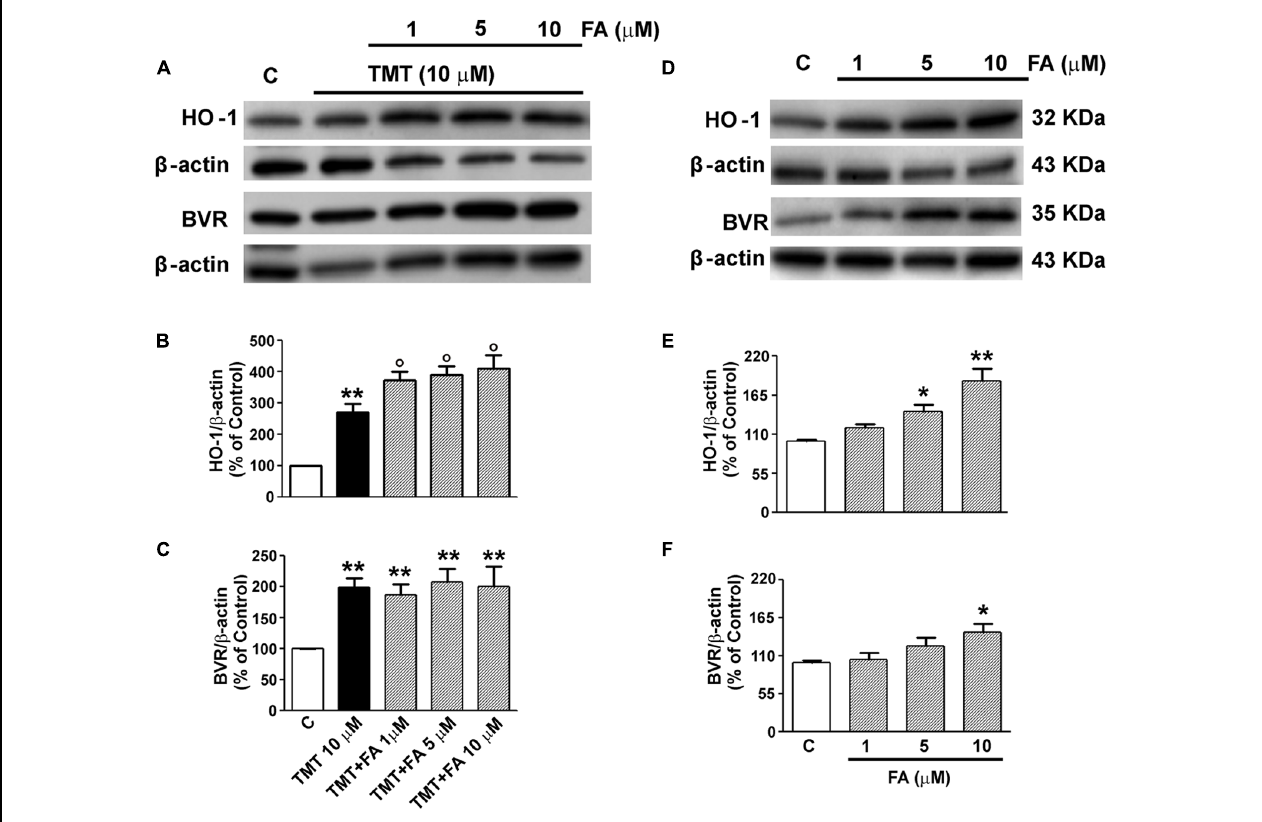
FIGURE 2 | Ferulic acid (FA) effects on TMT-induced heme oxygenase-1 (HO-1) and BVR expression in SH-SY5Y cells. SH-SY5Y cells were treated with FA (1–10 μ M) for 6 h and then incubated with TMT (10 μ M) for further 24 h (A–C) ; in another group of experiments SH-SY5Y cells were treated with FA (1–10 μ M) for 6 h and, subsequently, incubated with plain medium for additional 24 h (D–F) . Following incubation, cells were harvested and Western Blot was performed as described in the section “Materials and Methods.” (A) and (D) show representative gels regarding HO-1 and BVR protein expression. Bar graphs represent the quantification of HO-1 (B,E) and BVR (C,F) protein levels normalized for β -actin expression. Data are expressed as a mean ± SEM of eight replicates per group. ∗ P < 0.05 and ∗∗ P < 0.01 vs. controls, ◦ P < 0.05 vs. TMT. C, controls.